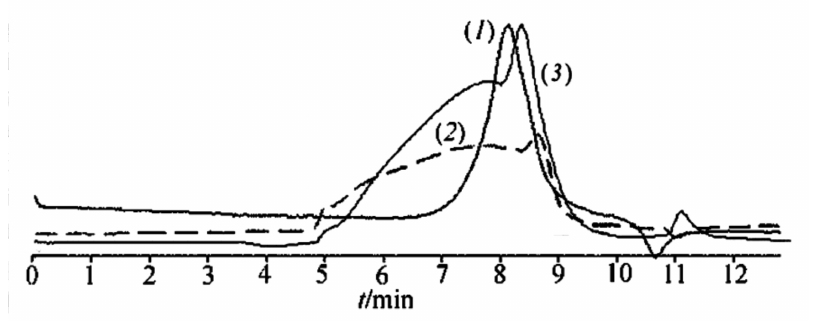
Figure 2. Gel-penetrating chromatography (GPC) tracks of LPOSSOs: ( 1 ) of product 5 , ( 2 ) of polymer 8 , and ( 3 ) of polymer 9